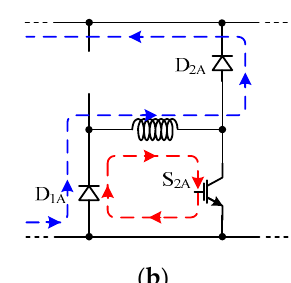
Figure 2. Current paths in the faulty bridge leg due to open-circuit failure in power device: ( a ) S 2 A , ( b ) S 1 A .